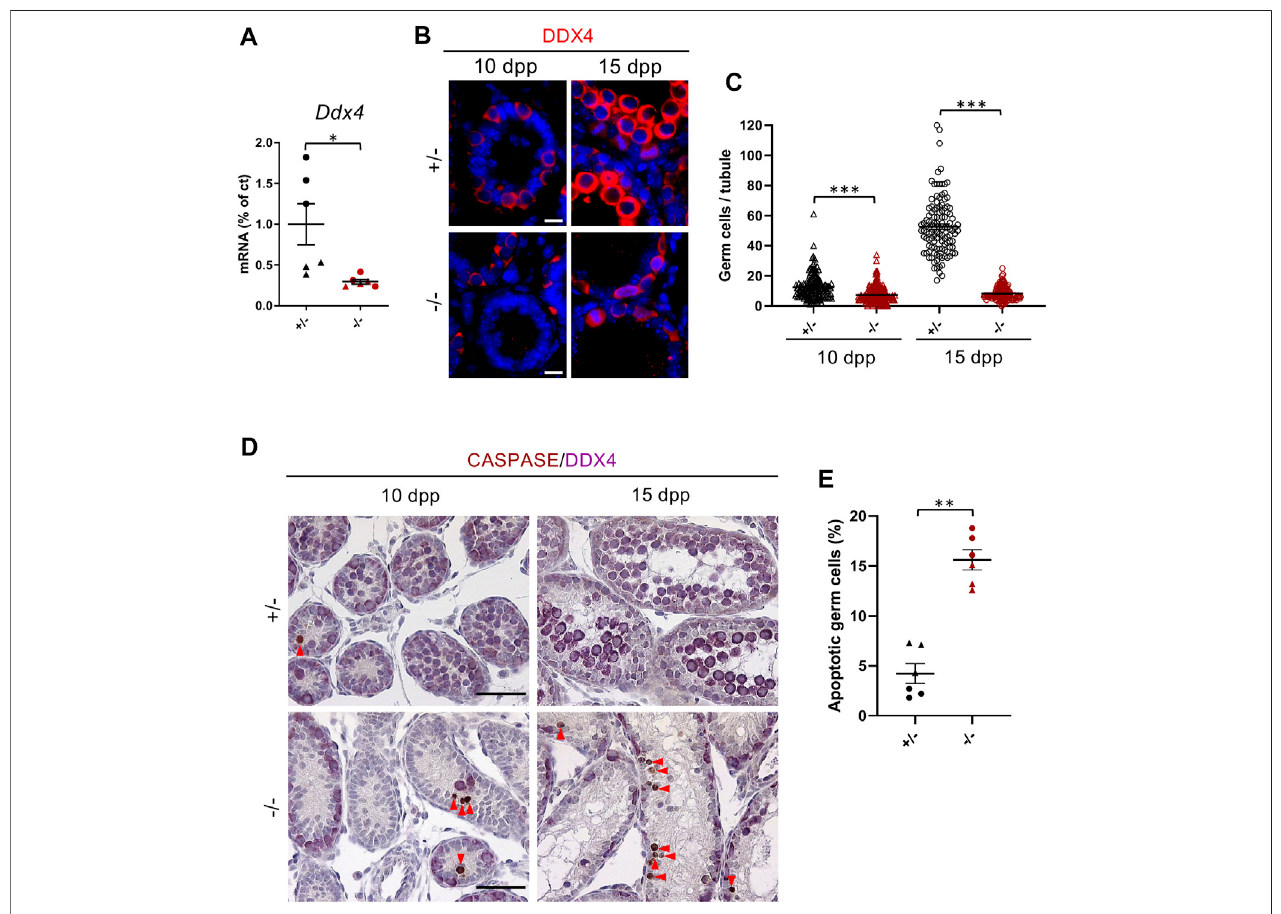
FIGURE 3 | Germ cell number is decreased in Cep250 -/- testes. (A) Ddx4 mRNA expression levels were measured by RT-qPCR in the post-natal testes. Triangles represent 10 dpp values and circles represent 15 dpp values. β -actin was used as an endogenous reporter. Data are expressed as a percentage of the control expressionlevel.Mean ± SEM.*** p < 0.001(two-wayANOVA). (B) Immuno fl uorescenceanalysisofDDX4(red)in10dppand15dpptestissections.DNAisstainedwith DAPI. Scale bar: 10 µm. (C) Quanti fi cation of the number of germ cells par tubule in 10 dpp and 15 dpp testis sections. Mean ± SEM. *** p < 0.001 (two-way ANOVA). (D) Histologicalanalysisof10 dppand15 dpptestissectionsstainedforDDX4(purple)andtheapoptoticmarkercleavedcaspase3(brown).Redarrowheads denote the germ cells stained for cleaved caspase 3. Scale bar: 50 µm. (E) Quanti fi cation of the percentage of apoptotic germ cells. Triangles represent 10 dpp values and circles represent 15 dpp values. Mean ± SEM. ** p < 0.01 (two-way ANOVA).